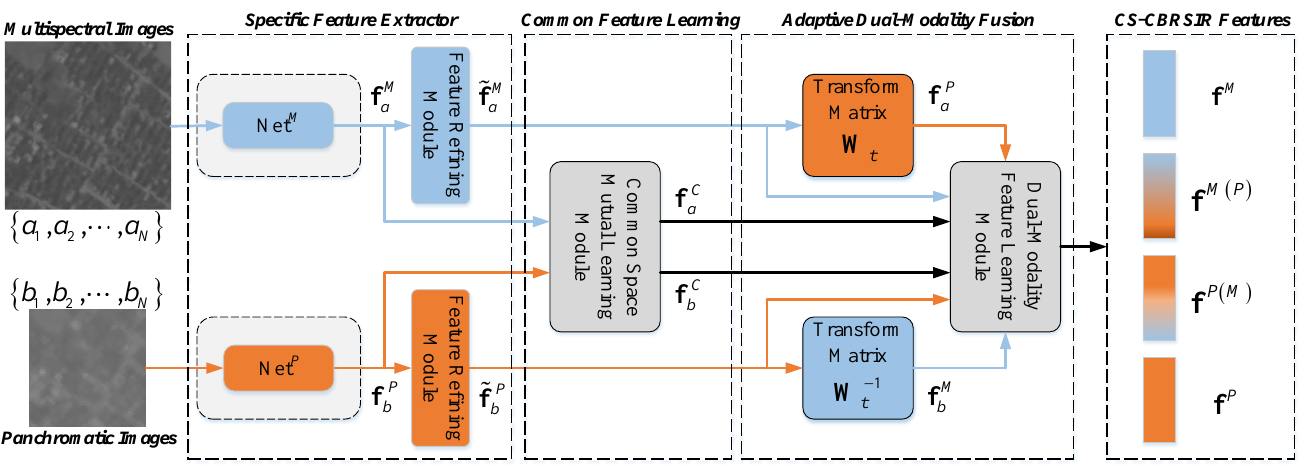
Figure 1. Framework of the proposed dual modality collaborative learning method. The multispectral and panchromatic images are first inputted into the specific feature extractor to extract their specific features f M a and f P , and refined specific features ˜f M a and ˜f P . Then, the common space features f C a , f C b b b can be generated by the common feature learning block using f M a and f P . To fuse the information b corresponding to different RS images and integrate the specific and common characteristics, ˜f M a , ˜f P , b f C a , and f C are inputted in the adaptive dual-modality fusion block. Then, the fused features f M , b f M ( P ) , f P ( M ) , and f P can be generated for the retrieval. The blue and orange streams illustrate the learning process of multispectral and panchromatic images,